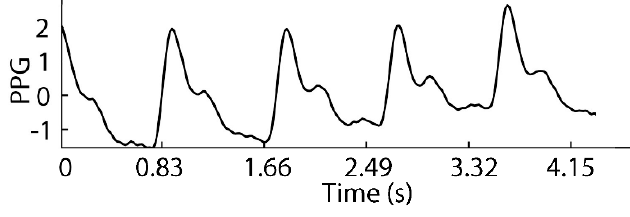
Figure 7. Filtered signal in SPW.